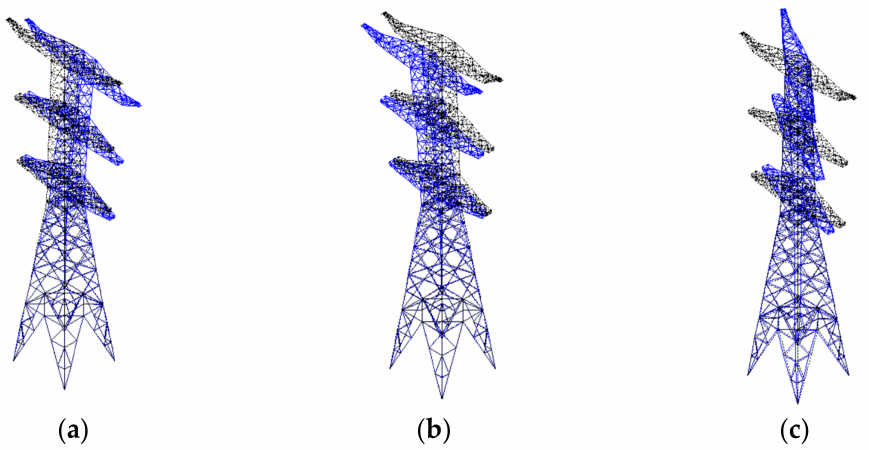
Figure 3. Vibration modes of a single tower: ( a ) first mode, 0.9370 Hz; ( b )second mode, 0.9582 Hz; ( c ) third mode, 1.3617